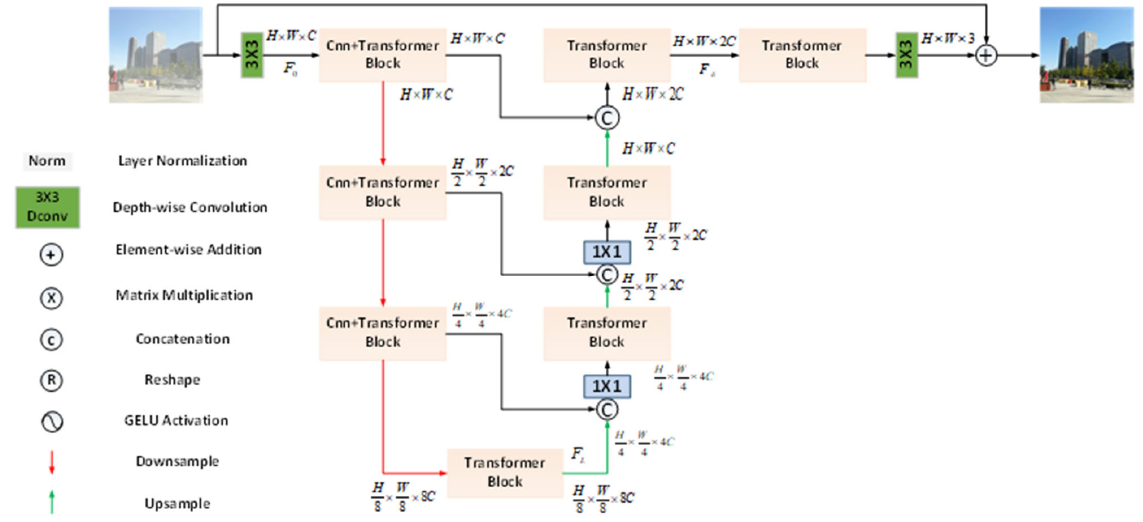
Figure 2. The overall network structure diagram.